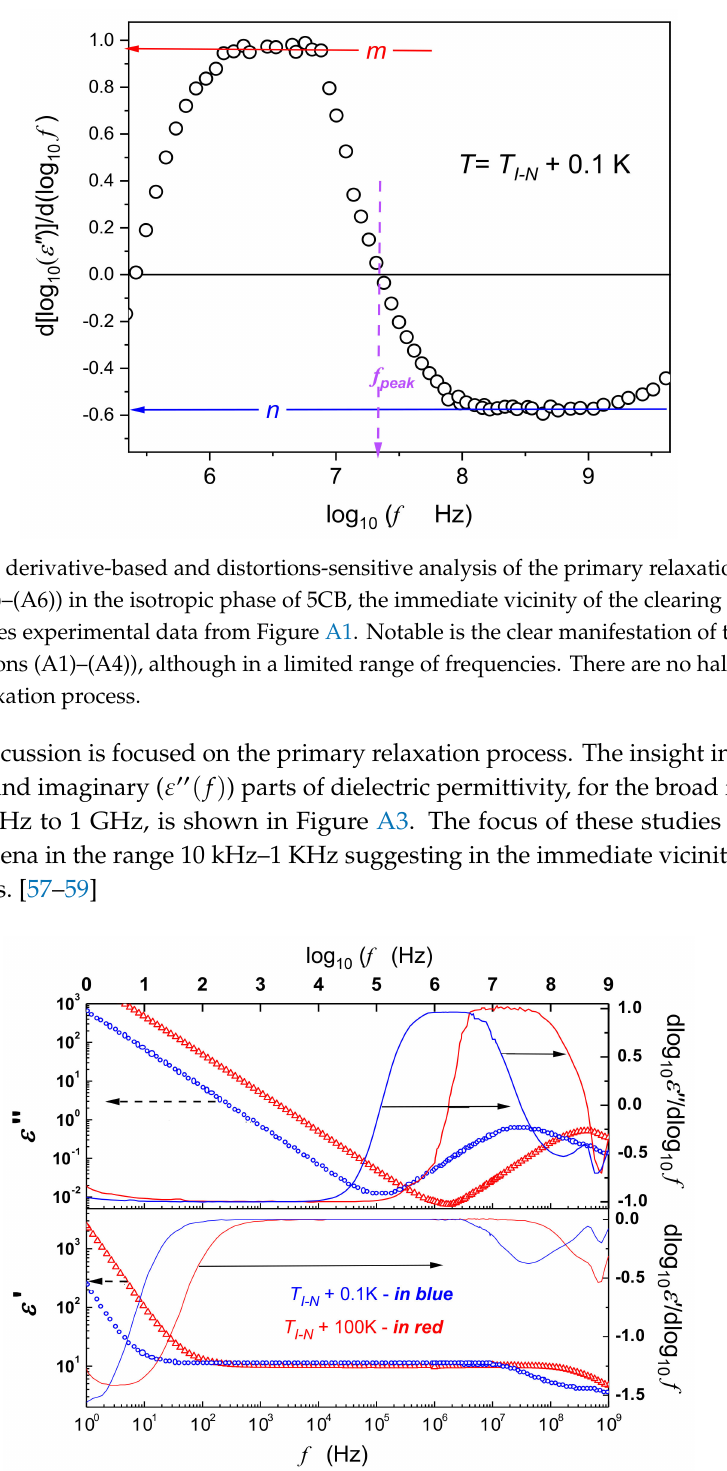
Figure A3. Broadband dielectric spectra for the real and imaginary parts of the dielectric permittivity spectrum in the isotropic liquid phase of 5CB. The tested range of frequencies extends from f = 1 Hz f = 0) to f = 1 GHz (log f = 9). Results are for the immediate vicinity of the I-N clearing (log 10 10 temperature (blue) and remote from the I-N discontinuous phase transition (red). For ε (cid:48) ( f ) data horizontal parts are for the frequency-independent dielectric constant ε (cid:48) ( f ) = ε . To reveal subtle features of spectra results of the derivative analysis of experimental data are also presented (solid curves, the right scale). Links between results / data and the left & right scales are indicated by